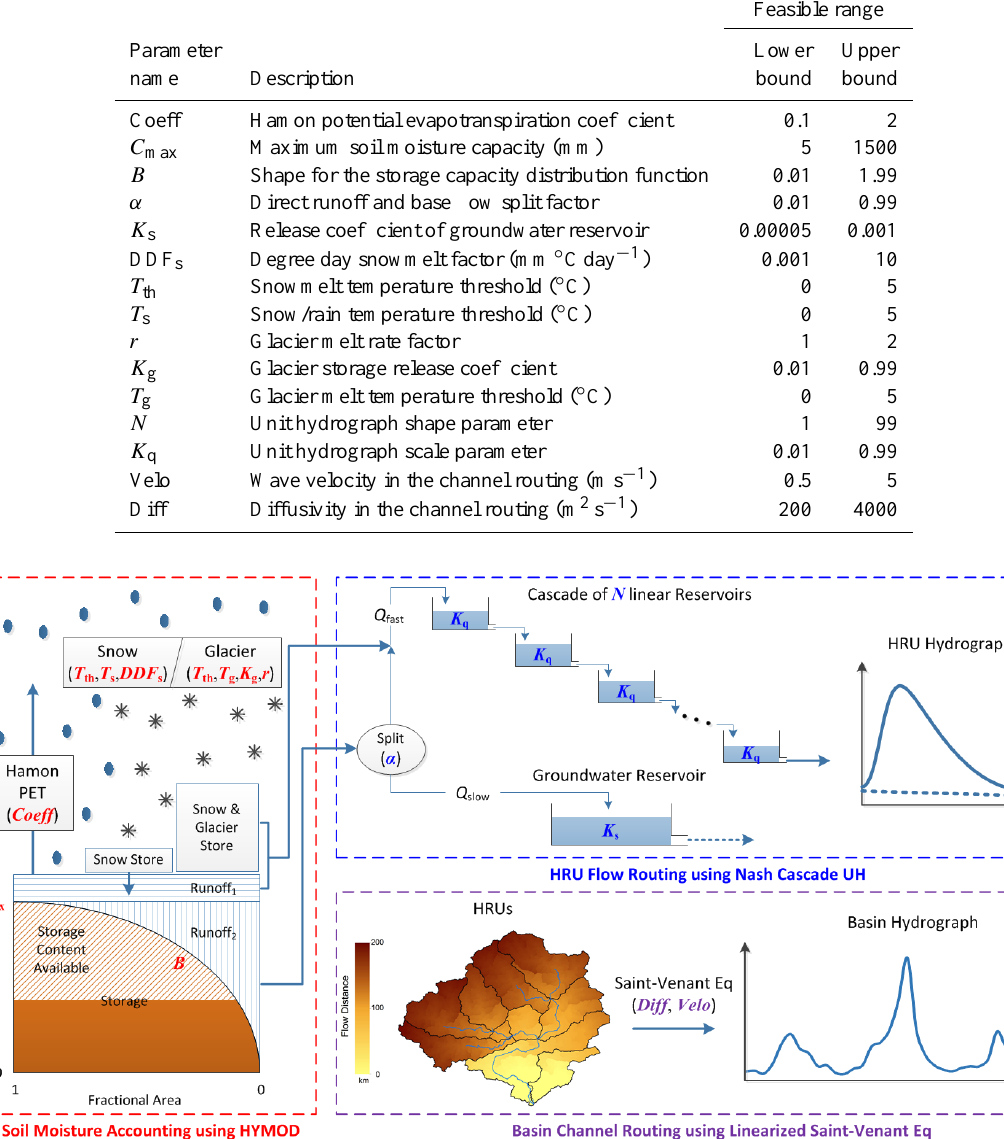
Figure 3. Distributed version of the HYMOD model